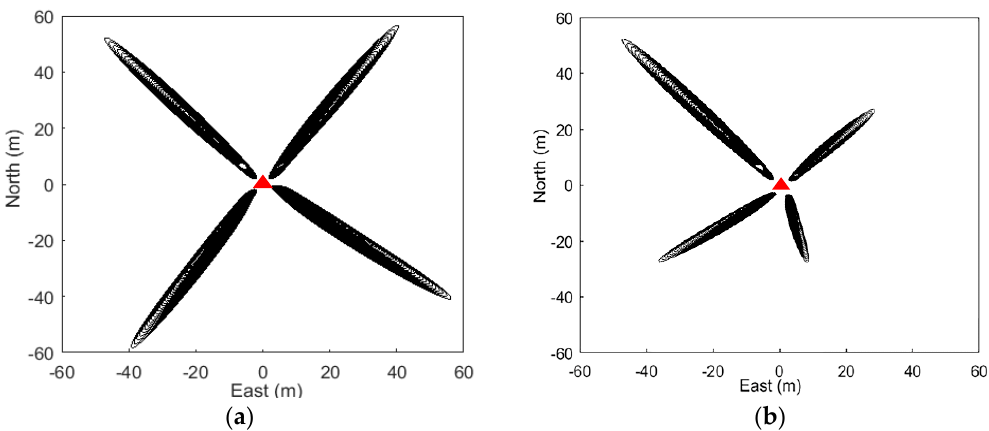
Figure 5. ( a ) First Fresnel Zone (FFZ) of satellite 7 (southwest and southeast) and satellite 8 (northwest and northeast) at p025 on a flat surface on DOY 2015-312; ( b ) FFZ of satellite 26 at p101 on a slope on DOY 2015-356, with the surface slopes of 14% (northeast), 0% (northwest), 7% (southeast), and 18% (southwest). All slopes went down from the antenna. Locations of GPS sites are shown with red triangles. Sensors 2019 , 19 , x FOR PEER REVIEW